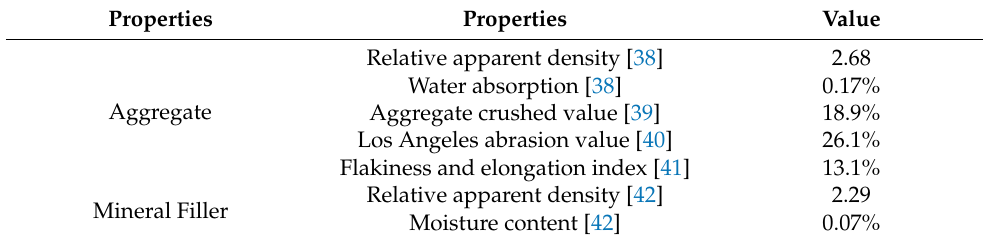
Table 1. Aggregate and mineral filler properties.